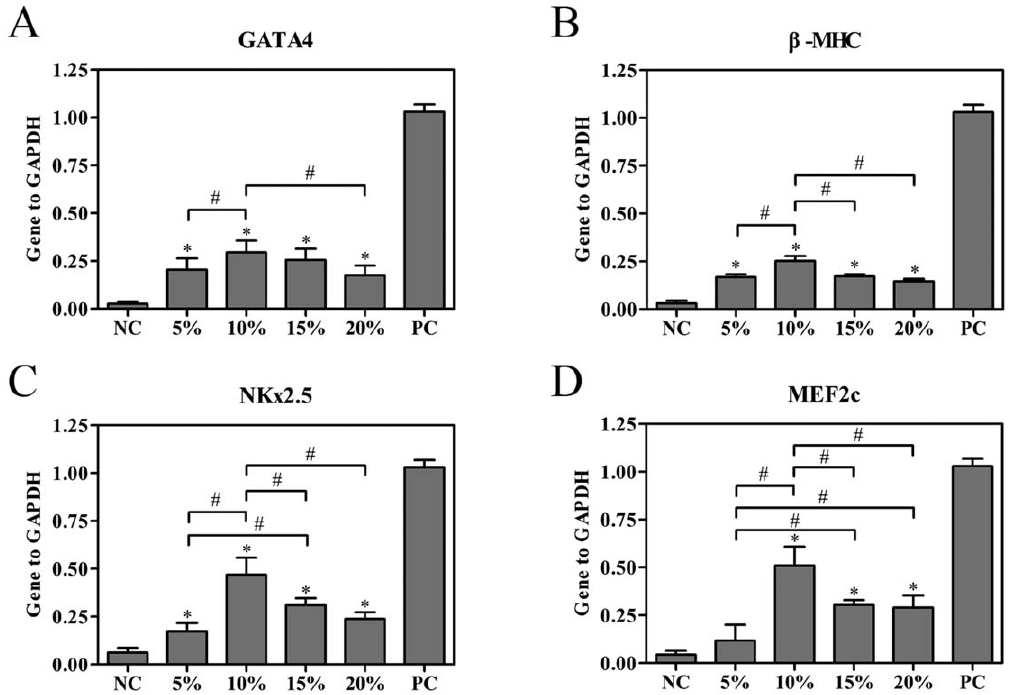
Figure 2. Effects of the magnitude of strain on the cardiac-related gene expressions of rBMSCs. rBMSCs grown on flexible membranes were subjected to 24 h of uniaxial strain resulting in 5%, 10%, 15%, and 20% elongation of the membrane at a frequency of 1 Hz and mRNA expression levels of GATA-4, b -MHC, NKx2.5 and MEF2c were evaluated on the 7 th day by quantitative real-time RT-PCR analysis. The expression of each gene was normalized based on the expression of GAPDH. (A) GATA4. (B) b -MHC. (C) NKx2.5. (D) MEF2c. NC, negative control (rBMSCs treated with regular complete medium); PC, positive control (normal neonatal rat cardiomyocytes). Results are shown as the mean 6 SD values (n=4). * P , 0.05 compared to the NC group; # P ,